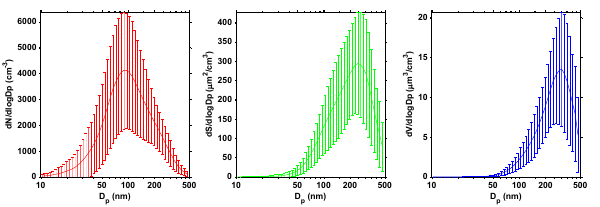
Fig. 12. Campaign average of number, surface area and volume distribution. Error bars represent one standard deviation from the average.